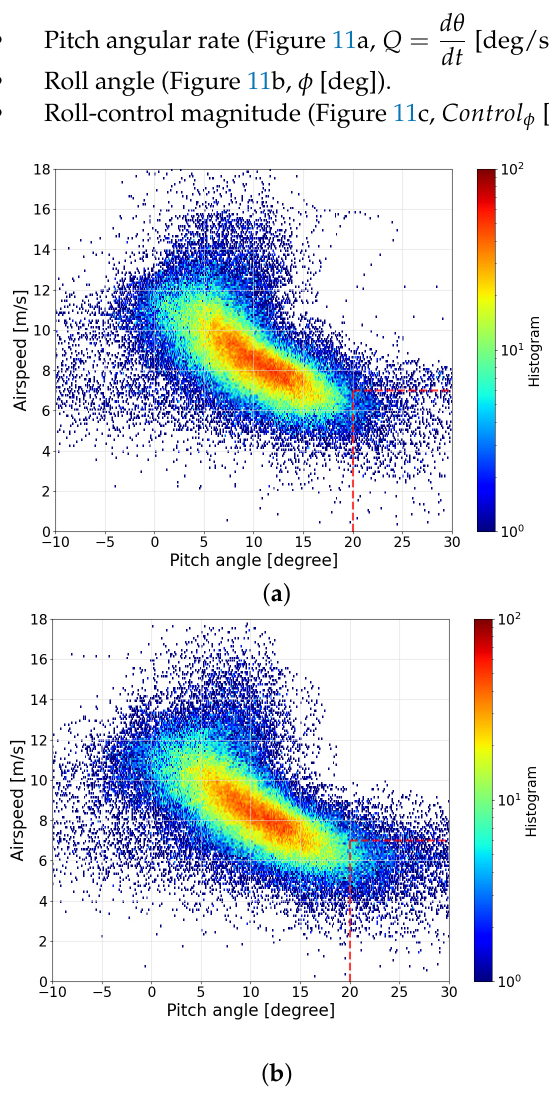
Figure 10. Histogram of flight log between the pitch angle and the airspeed. ( a ) DBD-PA OFF, ( b ) DBD-PA